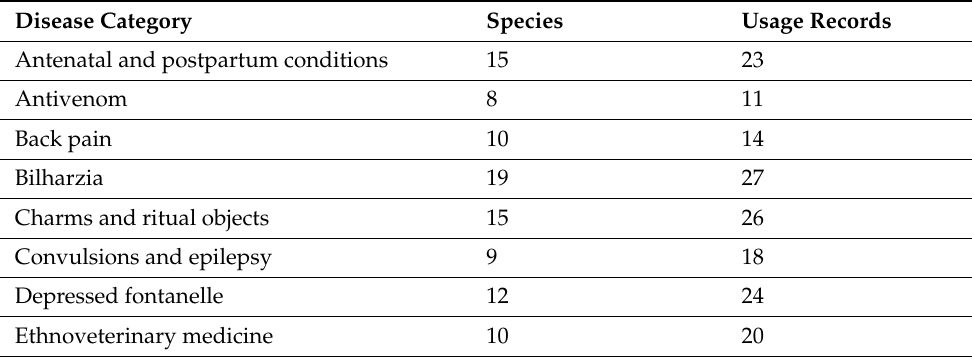
Table 2. Major disease categorises and Fabaceae species used as traditional medicines in Zimbabwe. Disease